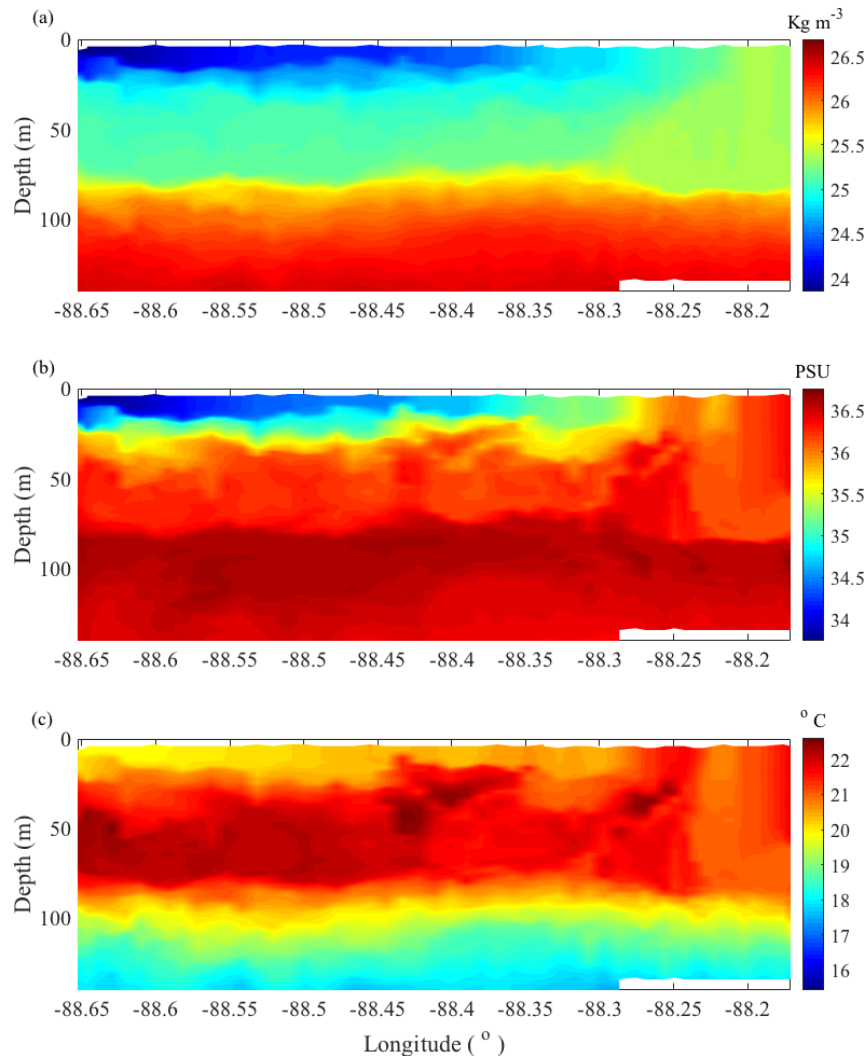
Figure 2. Potential density (a) , salinity (b) and temperature (c) data along the eastward-traveling transect shown in Fig. 1, measured by moving vessel profiler (MVP) conductivity–temperature–depth (CTD) casts taken on 28 January from 16:48 to 21:00UTC.